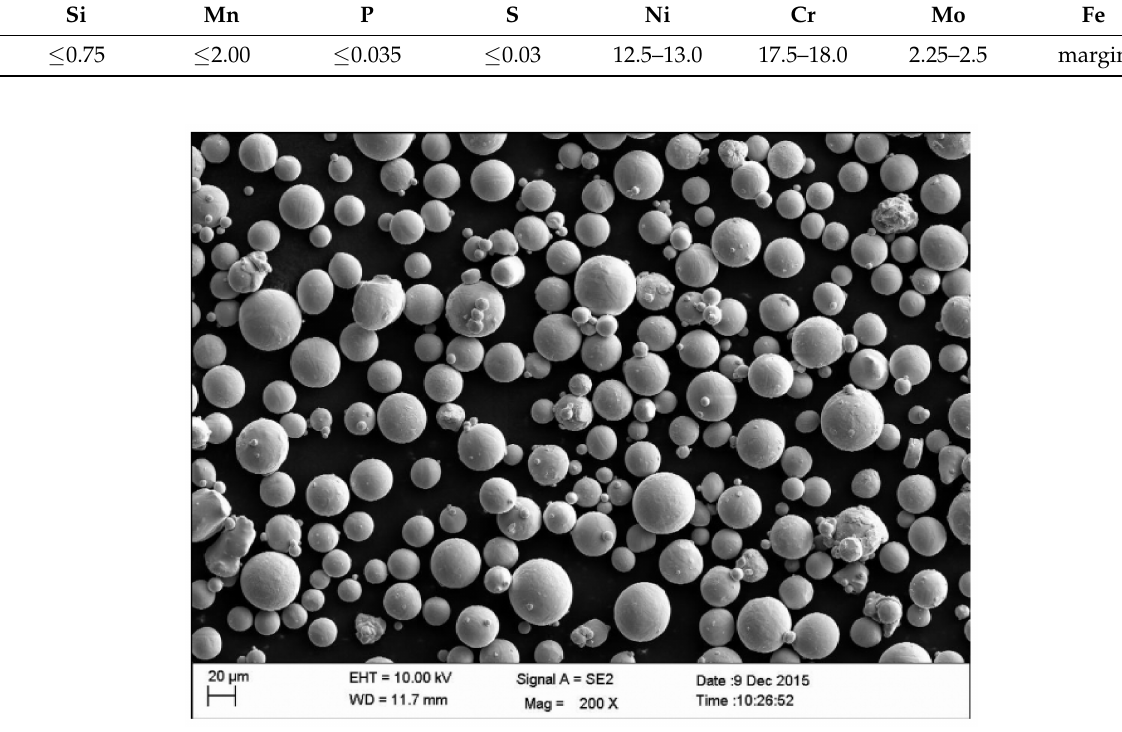
Figure 1. SEM of 316L stainless steel